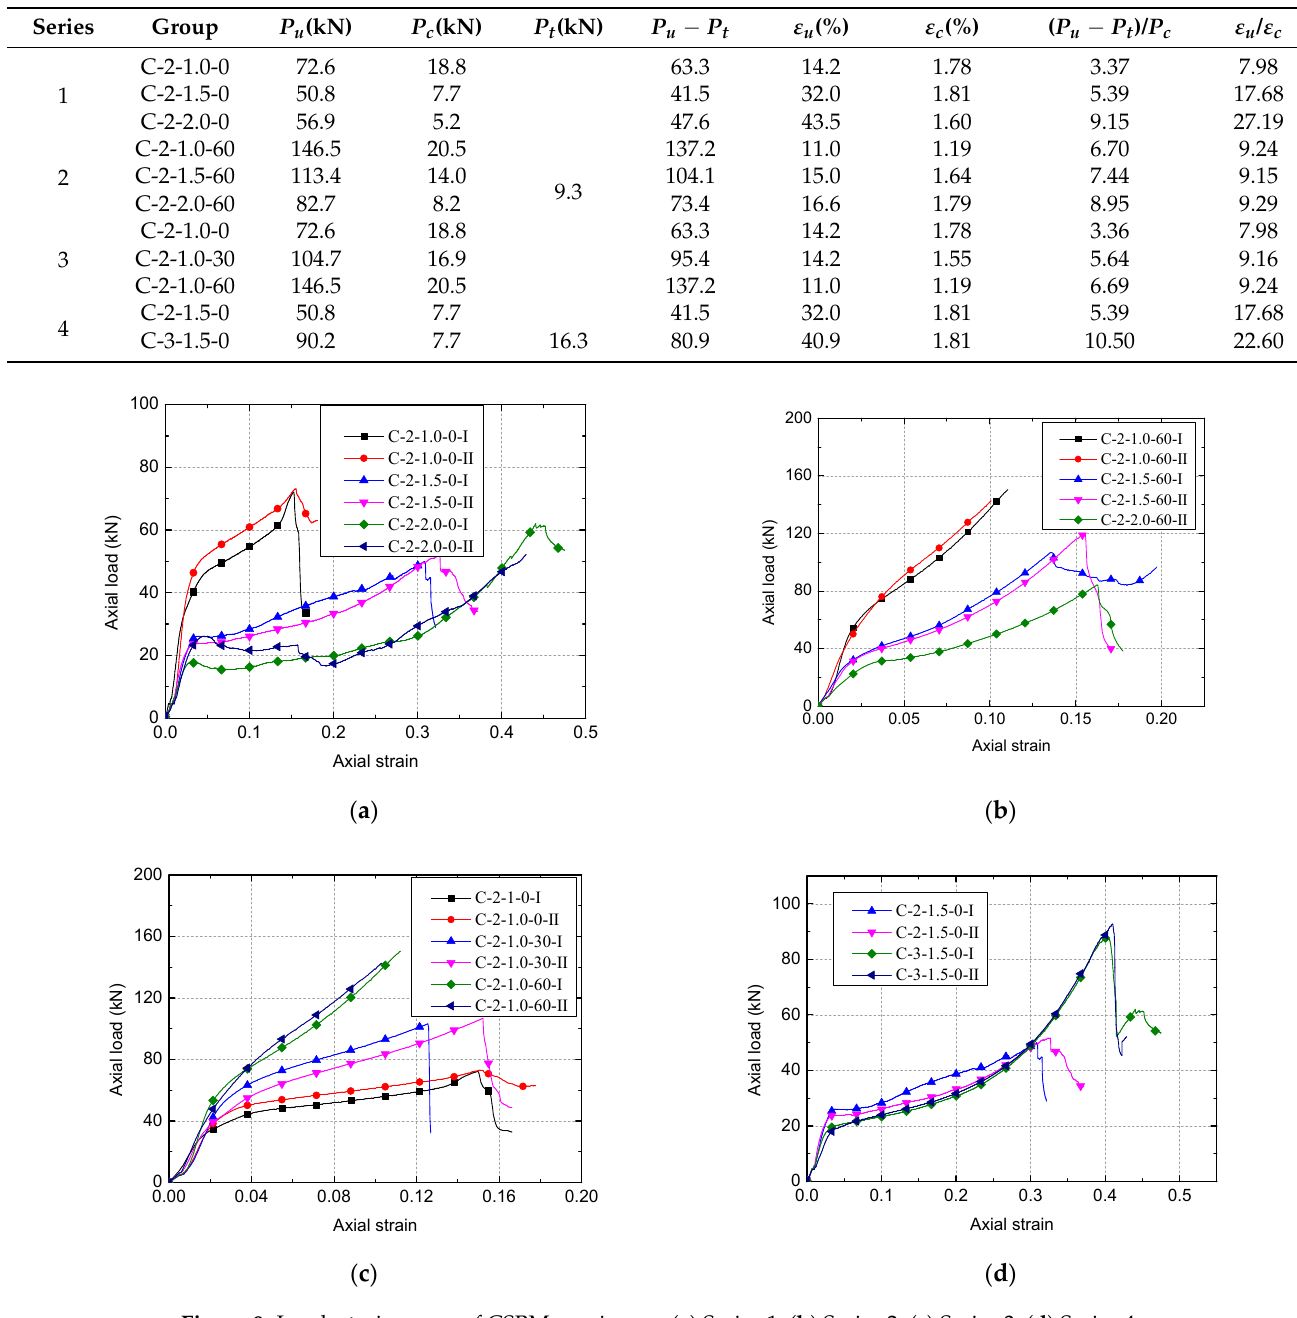
Table 3. A summary of key results.